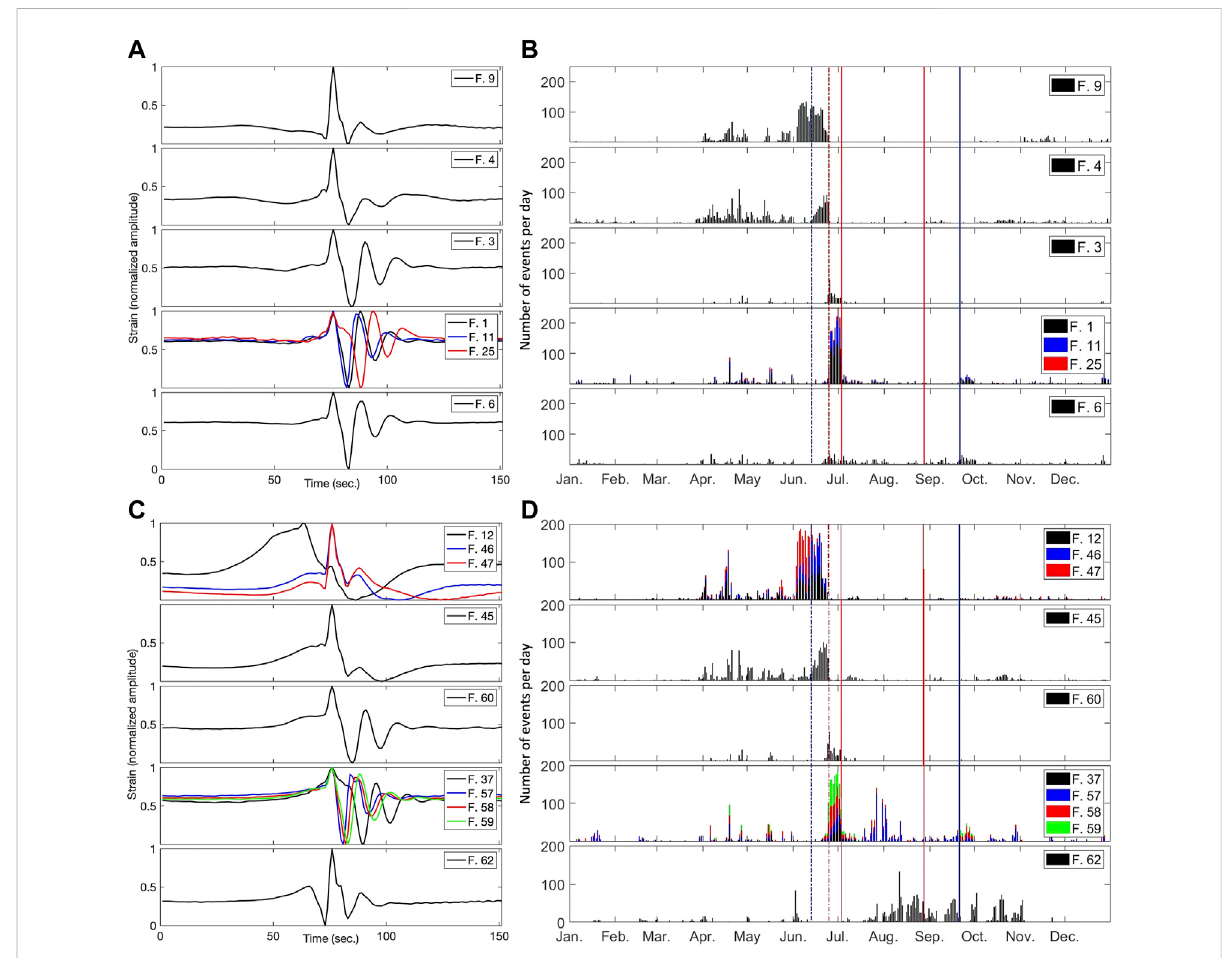
FIGURE 10 SOMclusteroffamiliescorrelatedwithdifferentvolcanicactivity (A,C) VLPandULPNormalizedstackedwaveformsrespectively.Thehorizontal axisindicatesthetimeinseconds (B,D) HistogramsofVLP-andULP-data.ThehorizontalaxisinBofthehistogramsindicatesthetimein2019Julian day. Both spectral intervals locate families whose cumulative number of events per day tend to change as July 3 paroxysm approaches. SOM algorithm fi ndsan “ ordinary volcanic activity ” familyin VLPand ULPiteration(families6and62, respectively). The bluedashedline marks theVT occurrence on June, 13; the red dashed line marks a major explosion; the two red vertical solid lines mark the two paroxysmal events; the blue solid line marks the lowering of the explosive activity